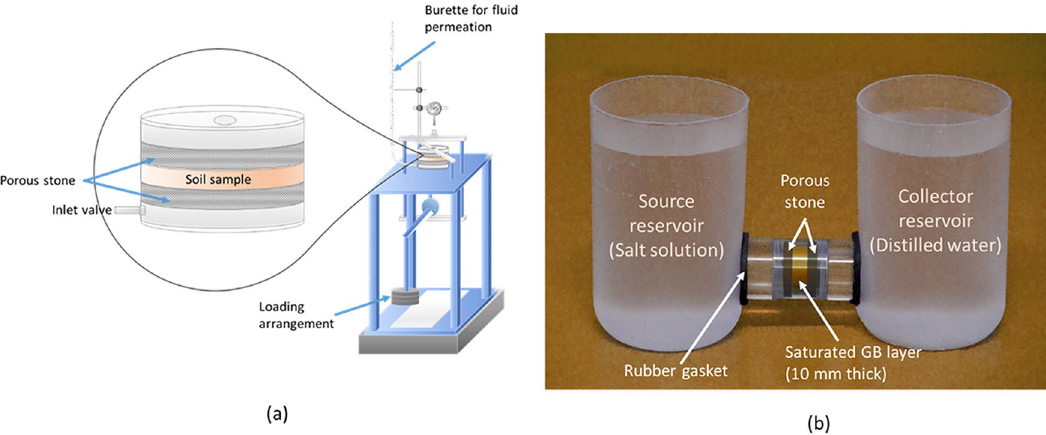
Figure 8. ( a ) Experimental set up for evaluating the sealing and volume change behaviour of compacted soil in the pore-fluid environment, ( b ) through-diffusion set